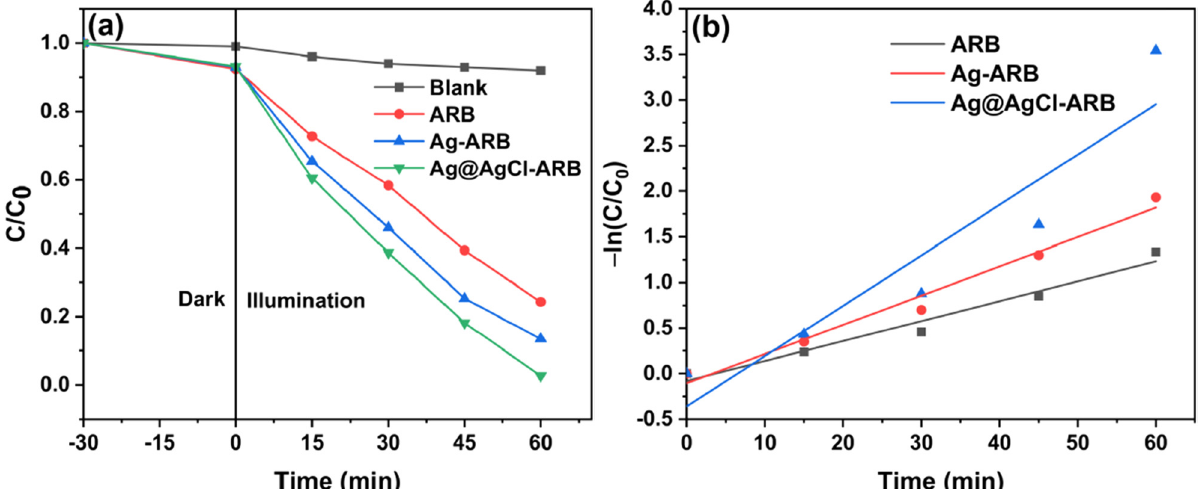
Figure 7: Degradation degree curves ( a ) and kinetic curves ( b ) of ARB, Ag - ARB, and Ag@AgCl –